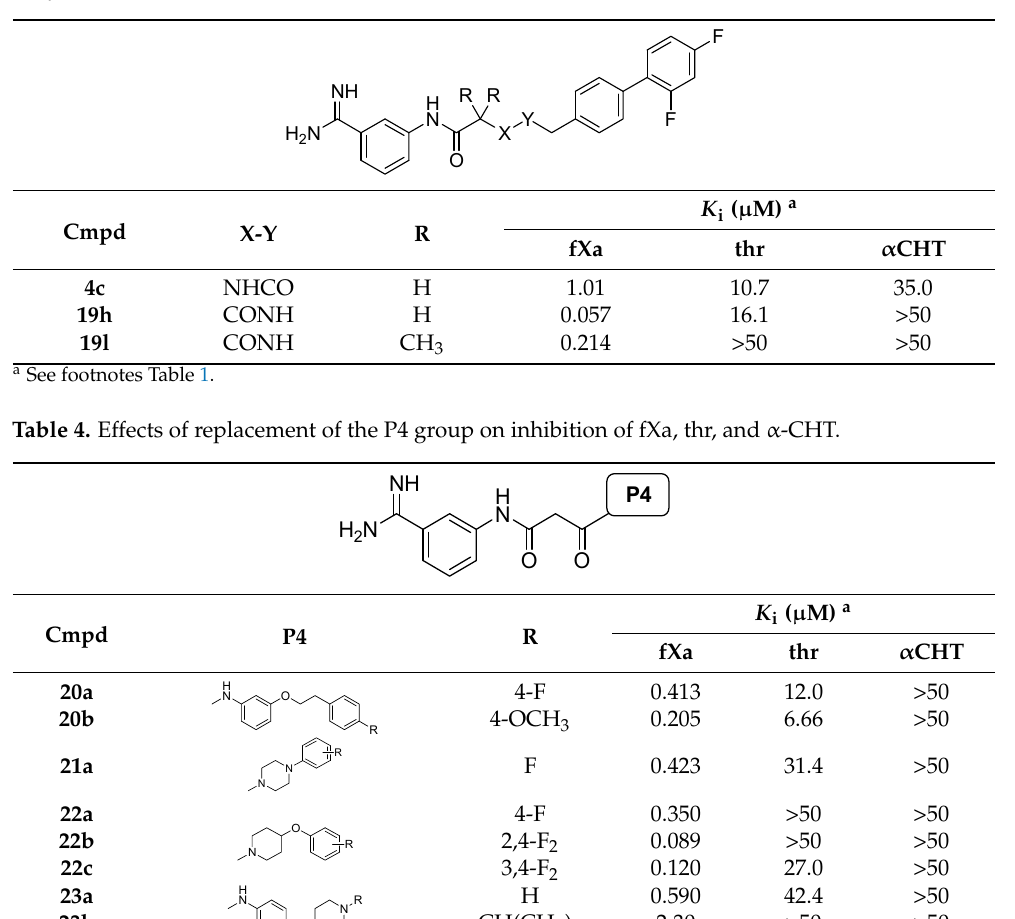
Table 3. Malonamide versus glycinamide comparison in the inhibition of the blood coagulation enzymes fXa and thr.